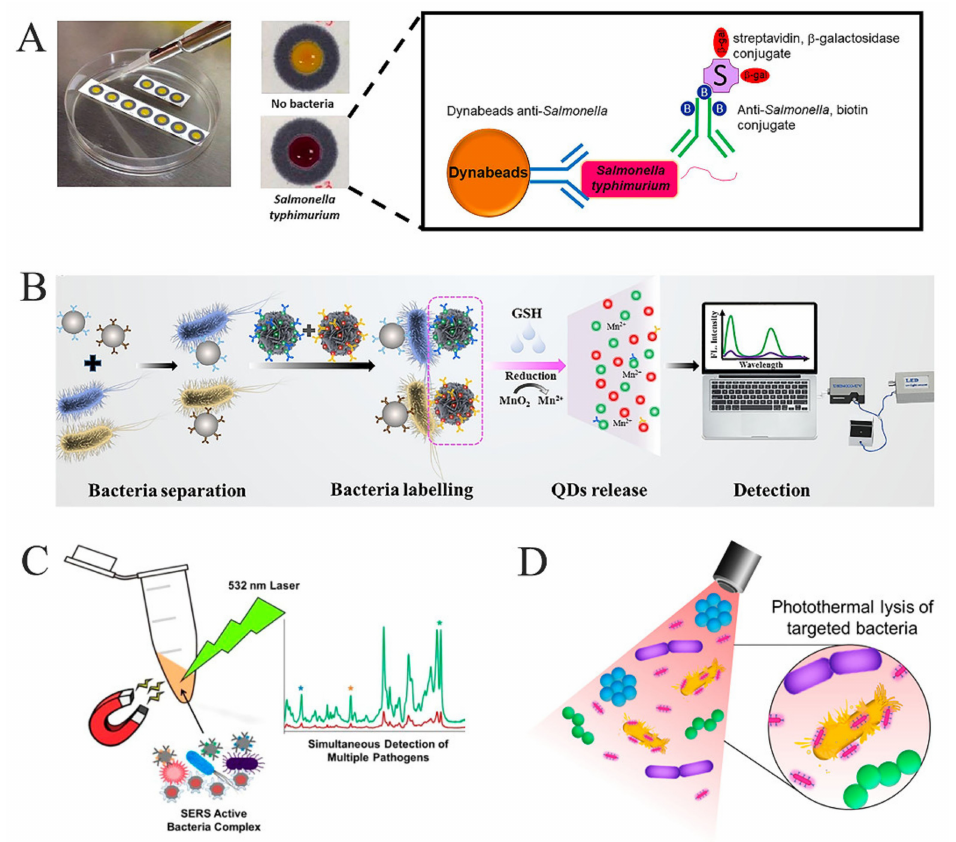
Figure 2. Optical sensing for Salmonella detection. ( A ) A paper-based colorimetric detection de- vice [62]. ( B ) Fluorescence immunoassay for Salmonella by the loading and release of quantum dots [64]. ( C ) Label-based signal detection strategy based on the surface-enhanced Raman spectral scattering [71]. ( D ) A sensing strategy of targeting lytic Salmonella by the photothermal effect of Au NPs